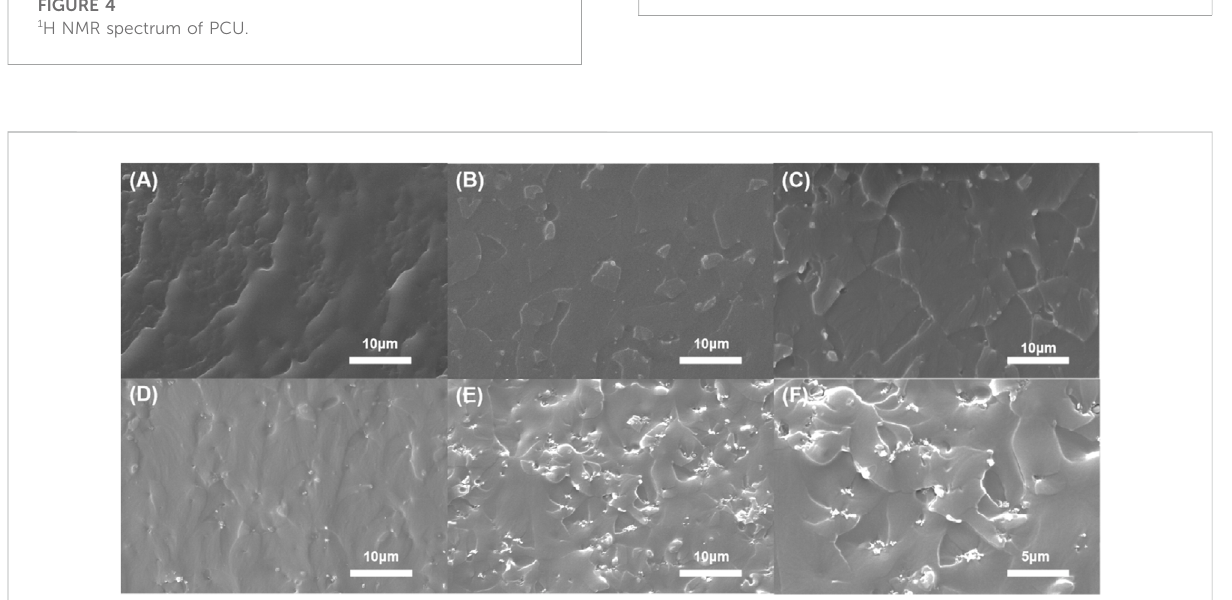
FIGURE 6 The stress-strain curves of the